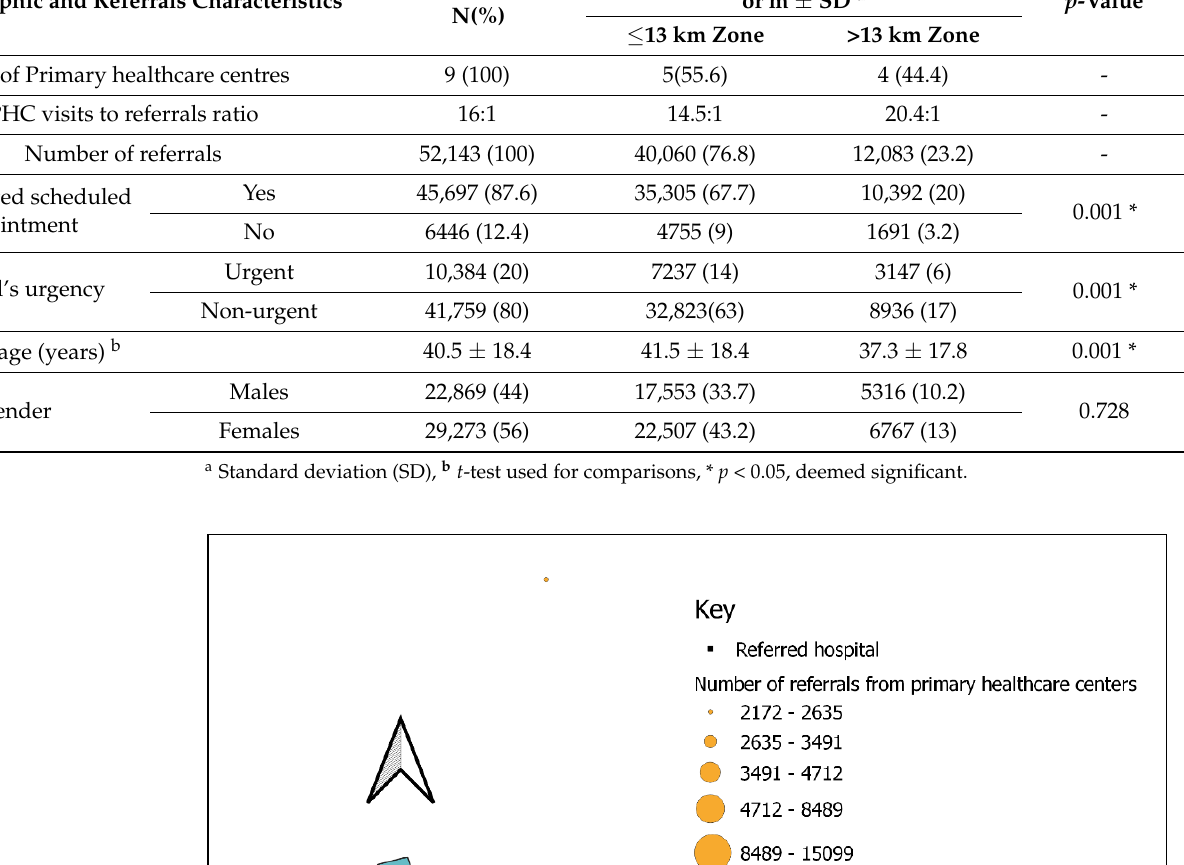
Table 1. Demographic and referrals characteristics based on the primary healthcare service’ distance from a referred hospital between 2019 and 2021 ( n = 52,143).